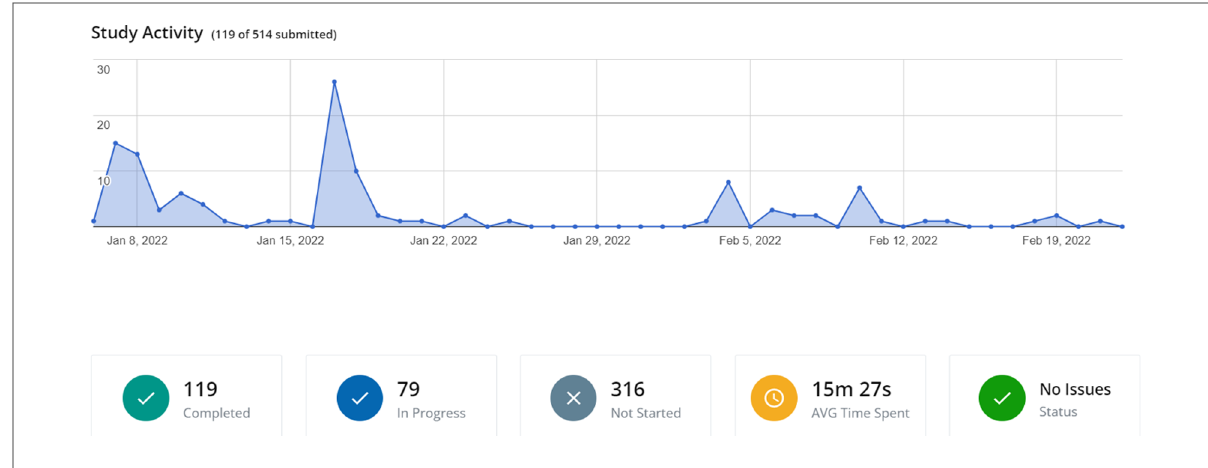
FIGURE 2 Study recruitment activity and information related to the participants.